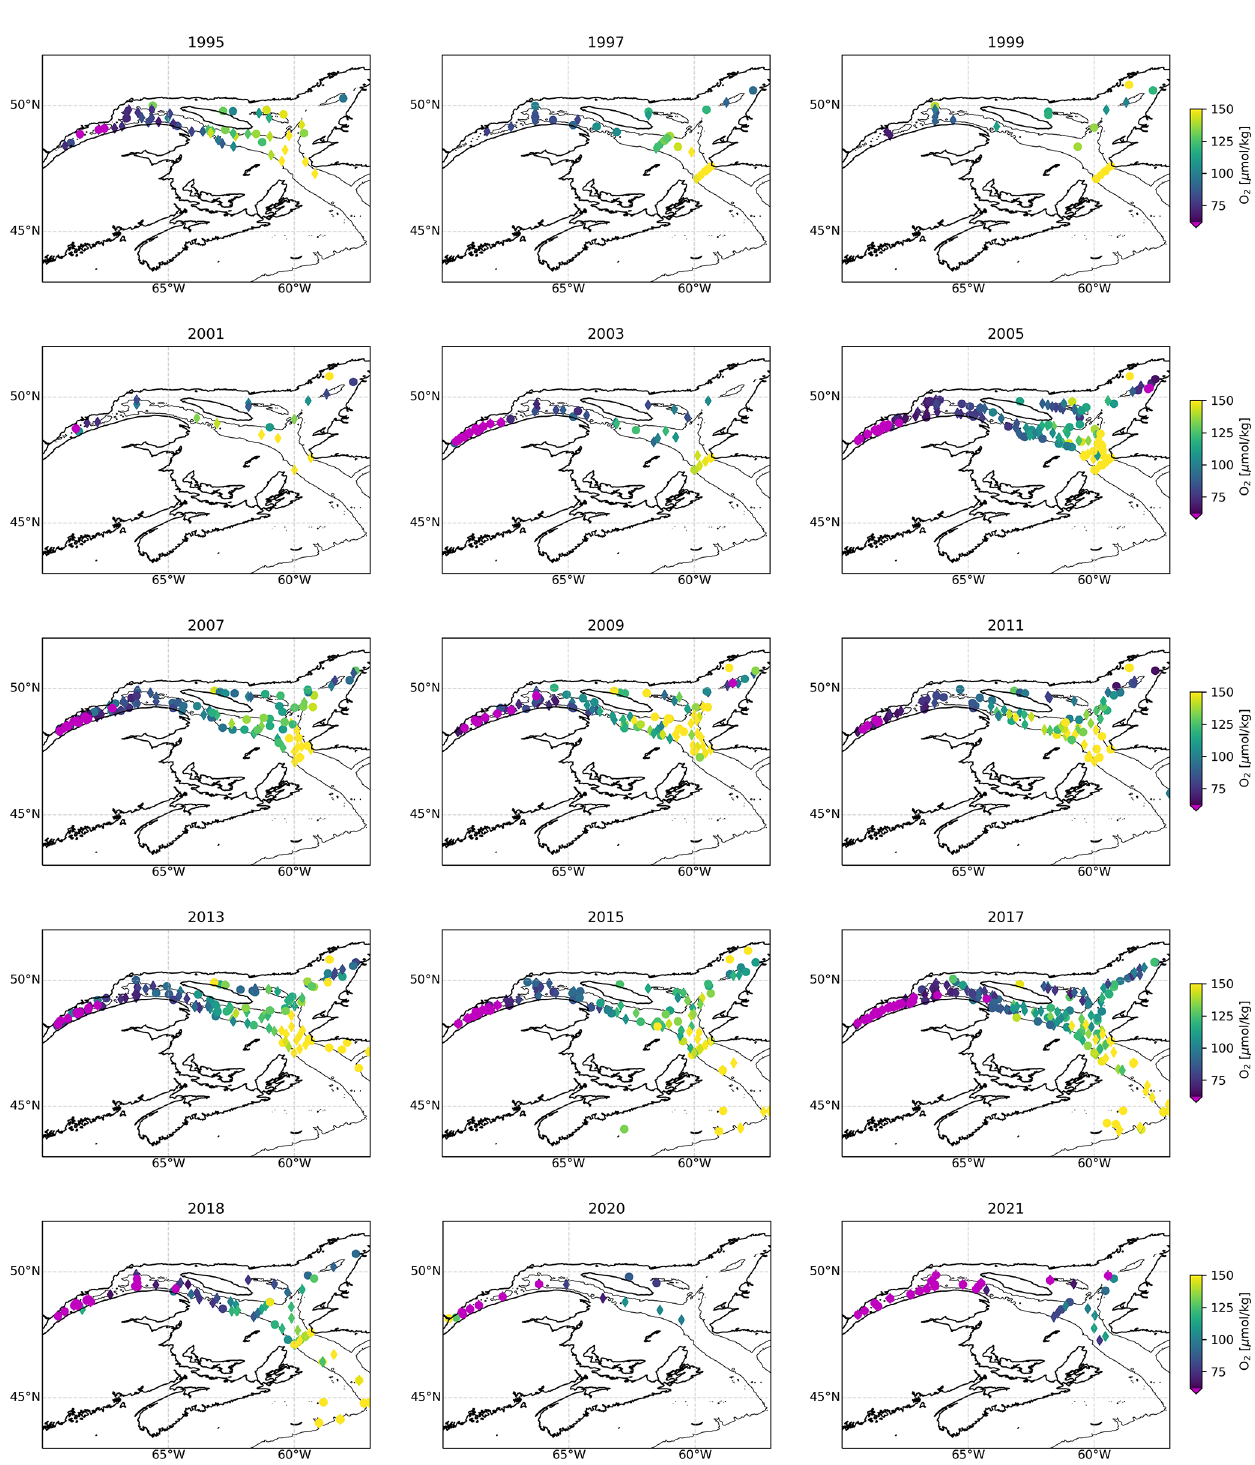
Figure 2. Maps showing a compilation of all dissolved oxygen (DO) samples collected every year since 1995 for every station sampled deeper than 200m. A map may contain data from multiple surveys carried out throughout that year. The color indicates the lowest DO concentration sampled over the water column, with hypoxic waters in magenta. The symbols indicate if the deepest sample is located between 200 and 250m (diamond) or below 250m (circle). The thin black lines delineates the 275m